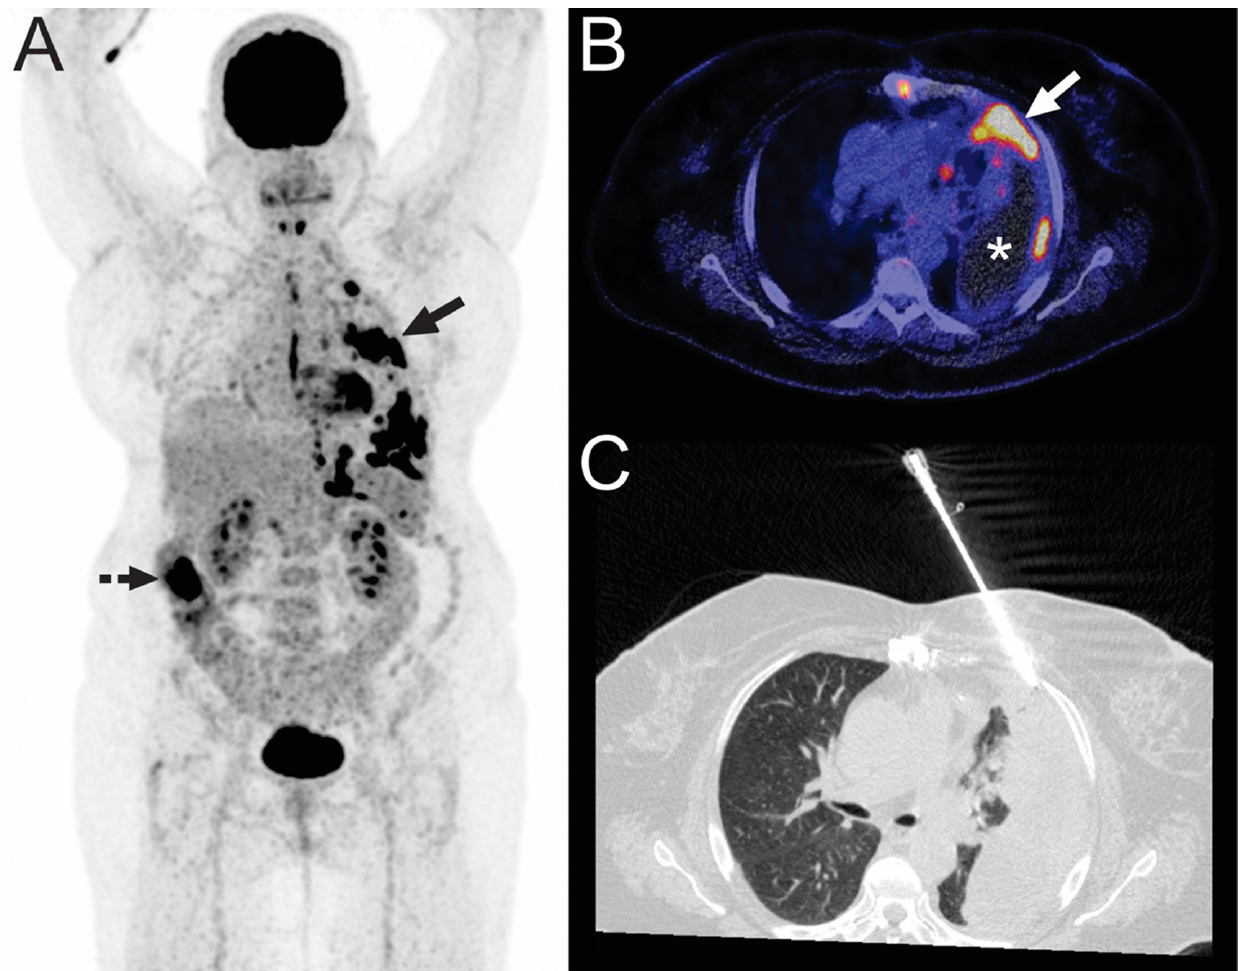
Figure 3. A 70-year-old woman with a known left-sided pleural effusion and a suspicion of lung cancer based on previous chest radiography and CT (not shown) was referred for FDG-PET. FDG-PET ( A ) showed multiple pleural lesions (continuous arrow), also demonstrated at fused FDG-PET/CT (( B ), arrow), along with a pleural effusion (( B ), asterisk). FDG-PET also showed an FDG-avid area in the ascending colon, which was interpreted as either physiological or due to diverticulitis or colitis by the attending nuclear medicine physician. CT-guided biopsy was ordered by the pulmonary oncologist to confirm the diagnosis of lung cancer and mutation analysis. CT image ( C ) shows the biopsy needle just before tissue sampling of one of the pleural lesions. Pathologic examination revealed intestinal adenocarcinoma and no lung cancer. Colonoscopy was performed, which demonstrated a tumor in the ascending colon that proved to be a well- to moderately-differentiated adenocarcinoma after